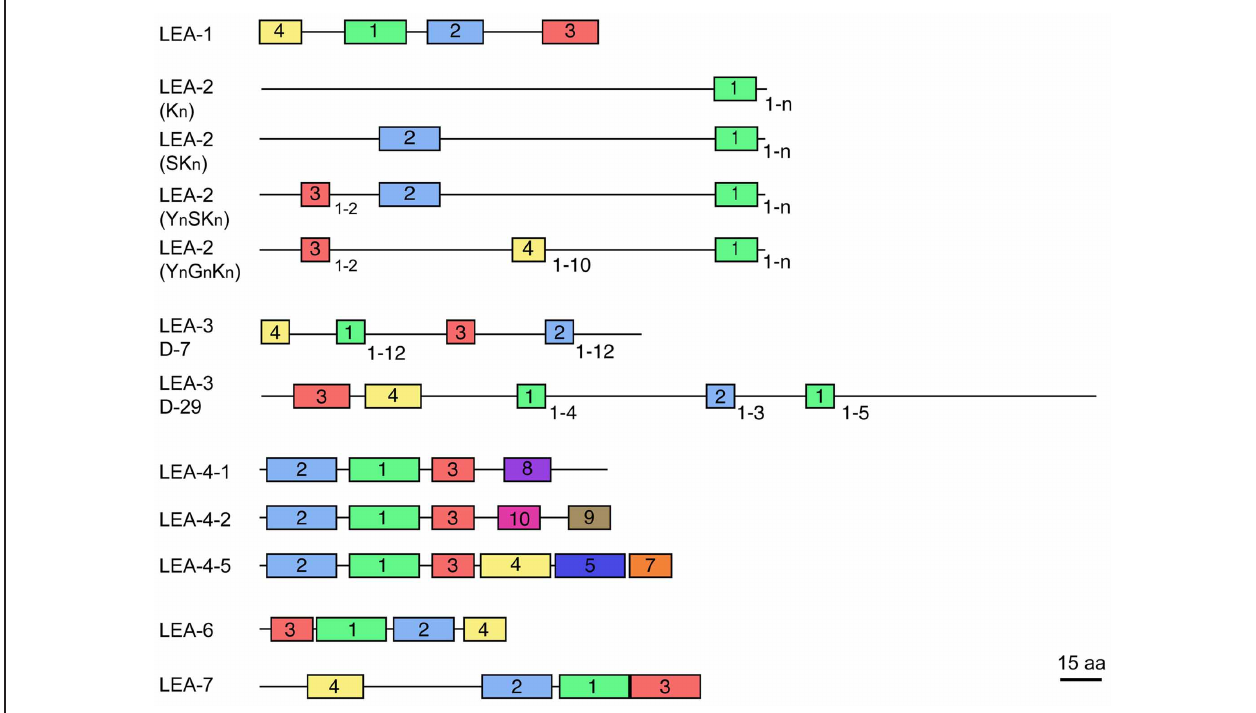
FIGURE 1 | Schematic representation of motifs distinctive for each LEA protein group (see Table 2). The different protein variants found in groups 2, 3, and 4 are shown. Colored blocks indicate the distribution of distinctive motifs in each group; equal colors between